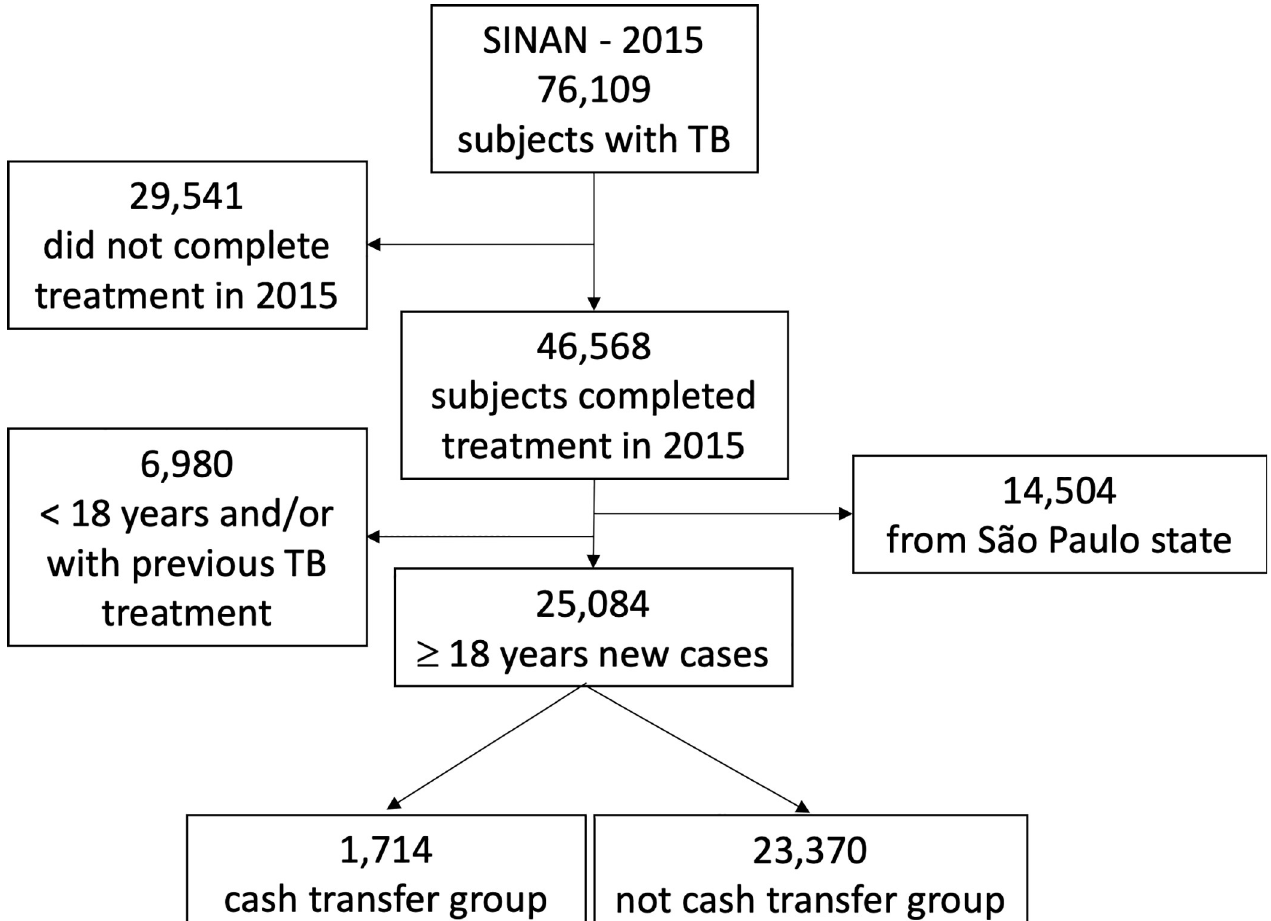
Fig 1. Flowchart of study sampling of people from the Brazilian Notifiable Disease Information System database (SINAN), 2015.